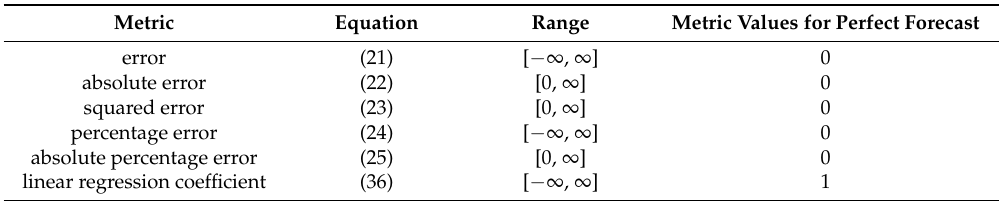
Table 4. Metrics of forecasting performance, their range and respective values when the forecast is